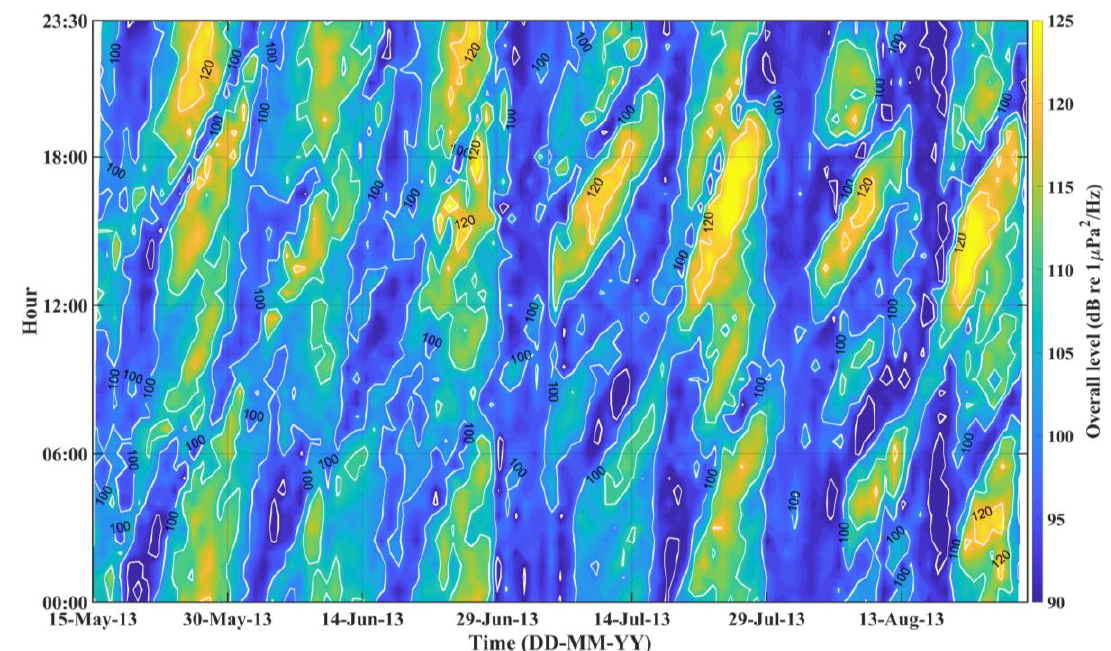
Figure 5. Overall levels of underwater noise (contour label interval, 10 dB) from 15 May to 27 August 2013.